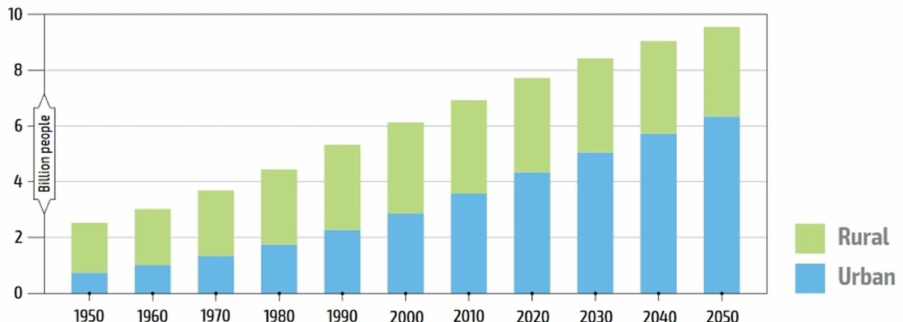
Figure 1. Global urban and rural populations: historical and projected. Source: [1].